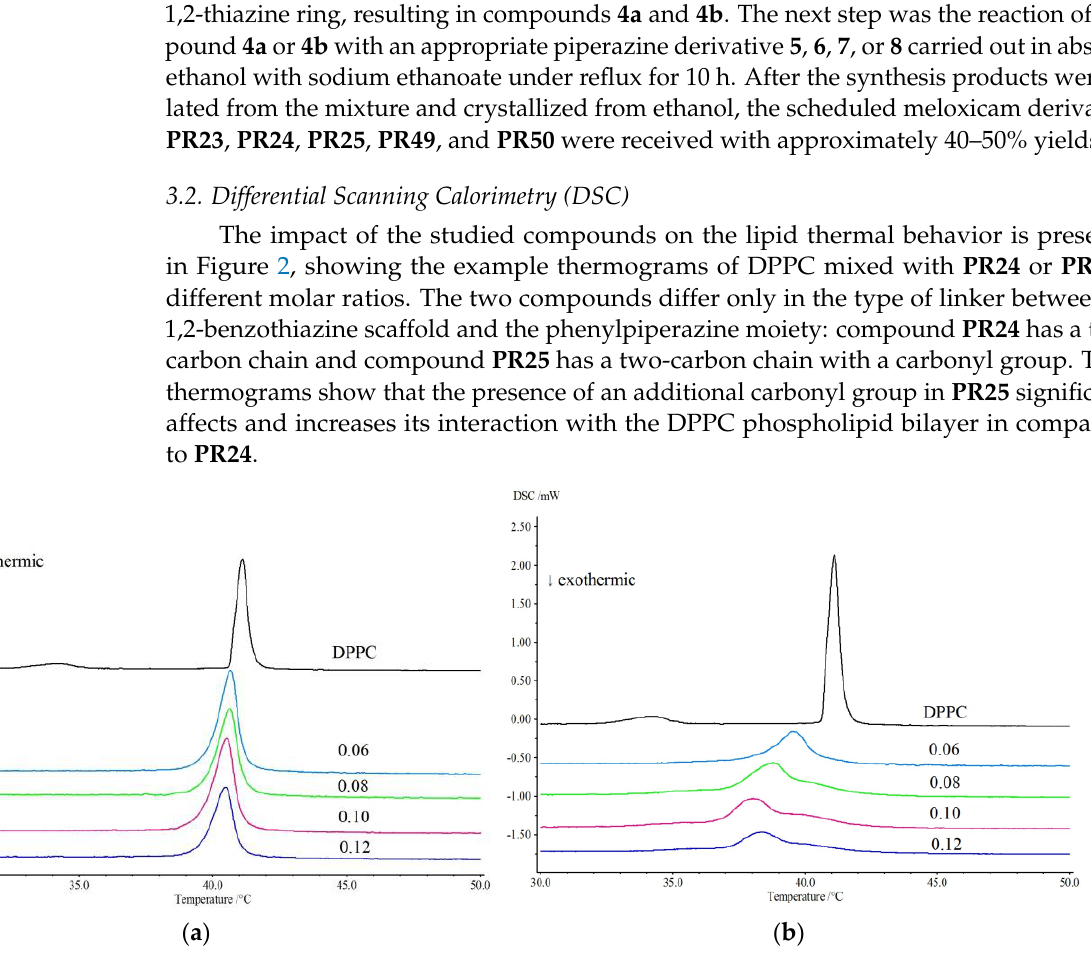
Figure 2. The example thermograms obtained for DPPC mixed with compounds: ( a ) PR24 , ( b ) PR25 , as well as for pure lipid (the first curve from the top — black color). Curves in the figure represent the thermograms obtained for different molar ratios (studied compound/DPPC—from the bottom: 0.12, 0.10, 0.08, and 0.06 and pure lipid). The exothermic direction in this graph is